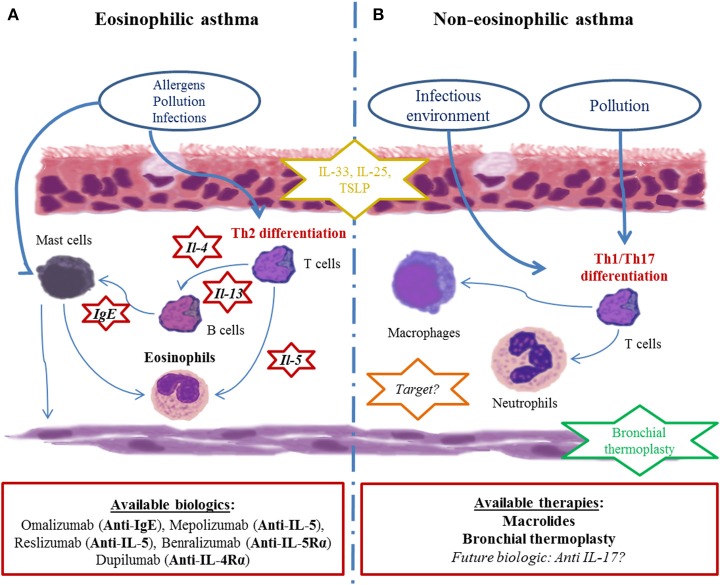
Current paradigm of asthma endotypes and related therapies. (A) Eosinophilic asthma is depicted as the most current clinical presentation. Driven by Th2 cytokines (IL-5, IL-4, IL-13), eosinophils chronically infiltrate bronchi and cause bronchial remodeling. Many biotherapies targeting those pathways (red-circled star) have been developed in recent decades. (B) Non-eosinophilic asthma physiopathology is poorly understood. Immune cells (mostly neutrophils and Th1 lymphocytes), cytokines (IL-17A and related molecules) and the immune pathway (inflammasome) seem to be involved, though their precise role remains unclear, restraining the development therapeutic drug targets (orange-circled star). Bronchial smooth muscle is an important therapeutic non-drug target because of bronchial thermoplasty (green-circled star). Subepithelial inflammatory cytokines (alarmins such as IL-33, IL-25, and TSLP) are of growing interest in both endotypes since they are far upstream of the inflammatory cascade (yellow-circled star).